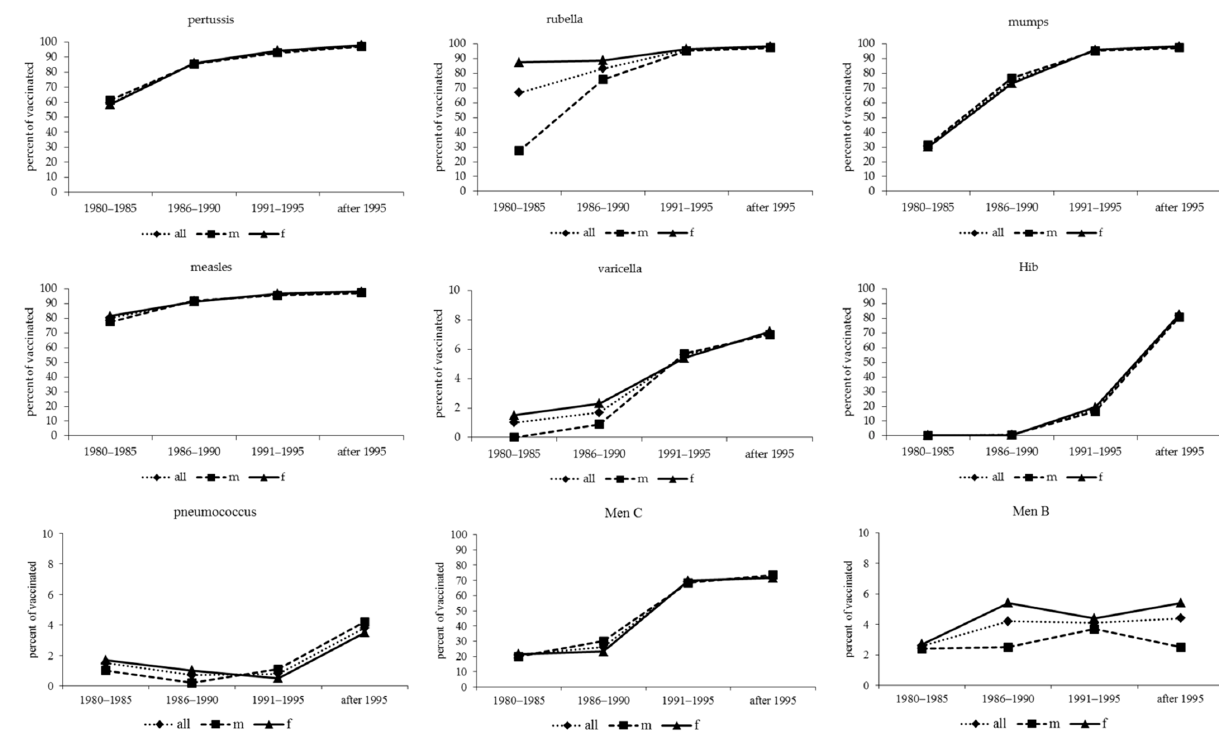
Figure 1. Compliance with vaccination against pertussis, rubella, mumps, measles, varicella, Hib, pneumococcus, Men C and Men B in pre-mandatory era. These vaccinations became mandatory for all newborns and those up to 16 years of age in 2017, except those against pneumococcus, Men C and Men B. Table 3. Summary of the overall data on the nine vaccinations. Percentage of students vaccinated against pertussis, rubella, mumps, measles, varicella, Hib, pneumococcus, Men C and Men B in total and subdivided according to sex. Statistical significance is related to the comparison between males and females. Vaccine All